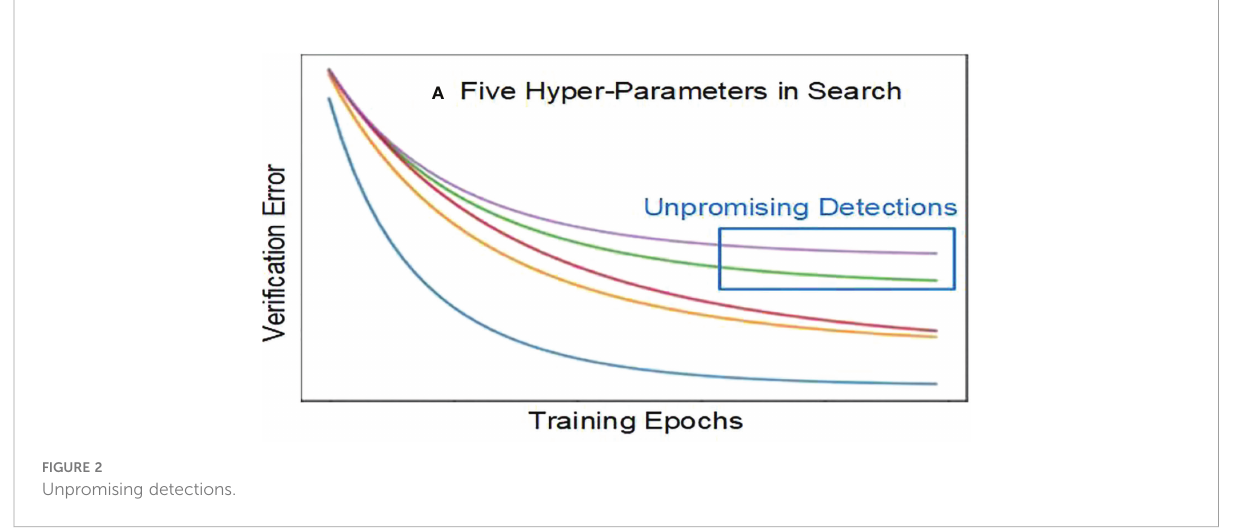
FIGURE 2 Unpromising detections.